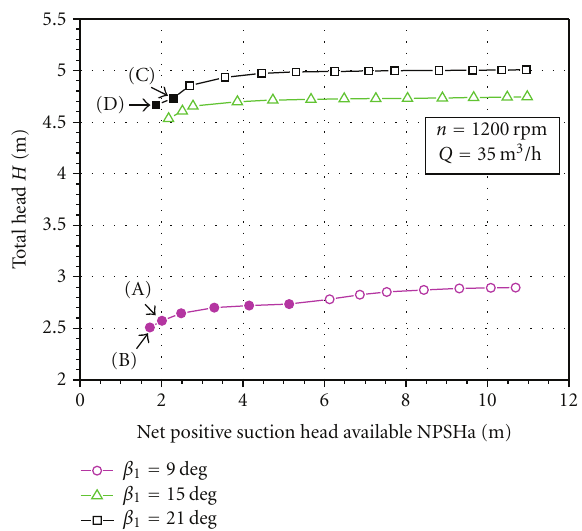
Figure 9: Total head drop curves, where cavitation has been developed to the filled points.